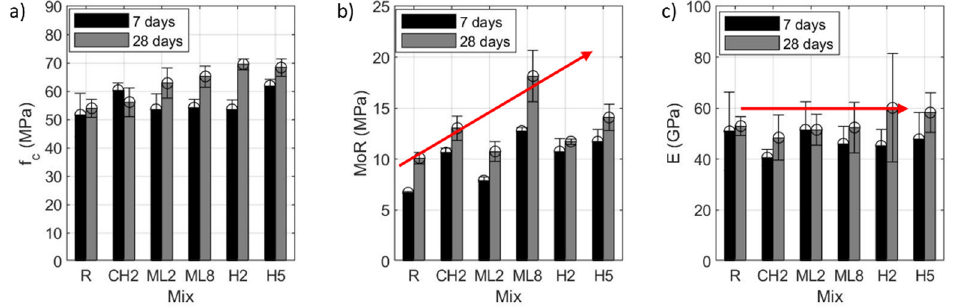
Figure 7. ( a ) Compressive strength, ( b ) modulus of rupture, and ( c ) modulus of elasticity for the reference and carbon fiber reinforced cementitious composite mixes at 7 and 28 days of age.